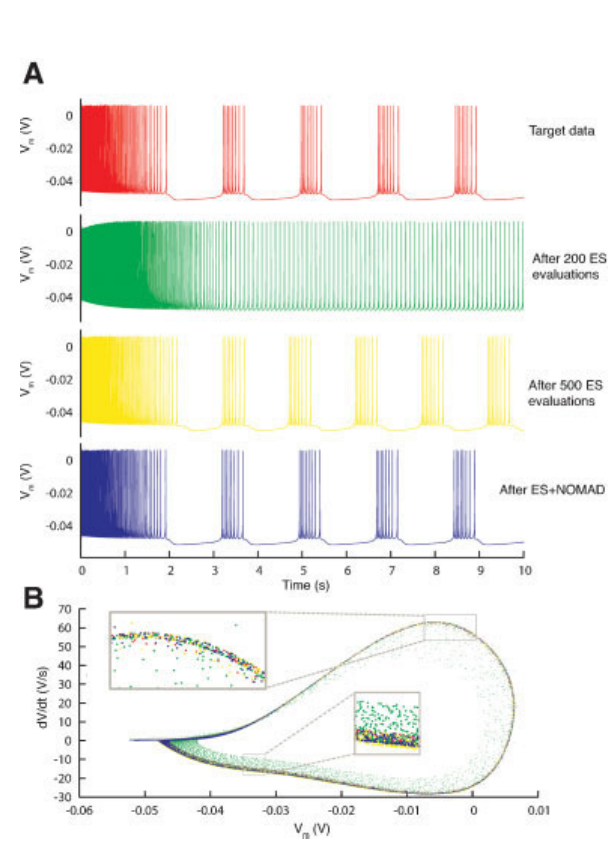
Figure 11. Resulting traces . ( A ) Somatic membrane voltage traces of the target data (red), the best model found by an ES optimization after 200 (green) and 500 (yellow) evaluations, and by a NOMAD search that started with the best solution found by ES (blue). The respective error values are 0, 6.7, 4.1, and 2.6. ( B ) Phase-plane trajectory of the traces in A (same color code). The densityofthetrajectoryisnotvisible,sinceonelocationontheplotcancontain many overlapping data